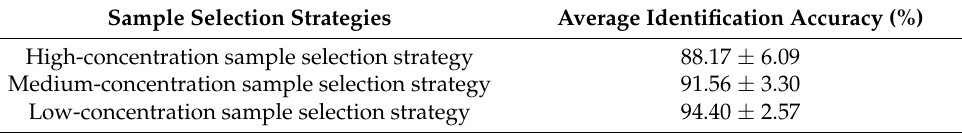
Table 4. Average ethylene gas identification accuracy of WOA-LSTM with the single-concentration level sample selection strategy. The training samples were selected from high-concentration, medium- concentration, or low-concentration ethylene samples.